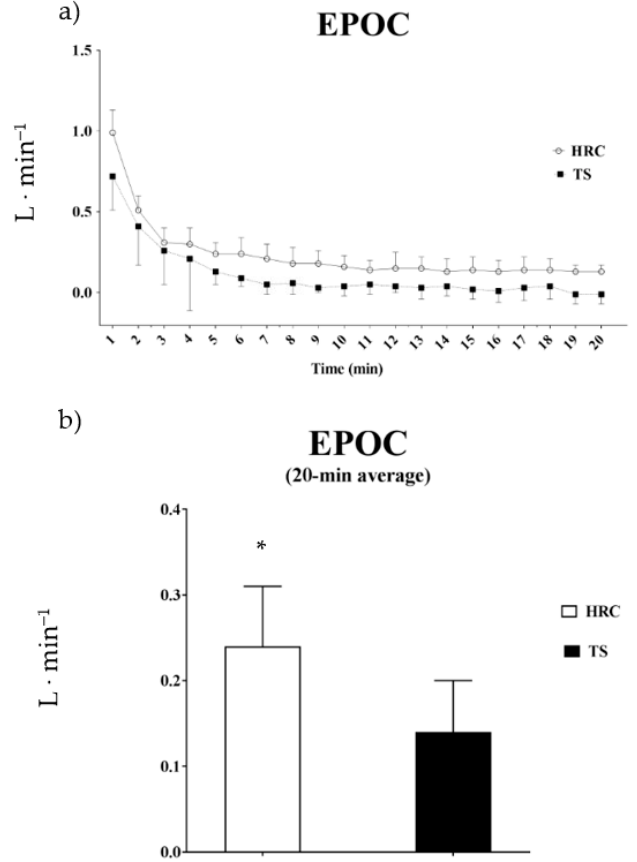
Figure 3. Excess post-exercise oxygen consumption after training session. EPOC = excess post-exercise oxygen consumption after training session. ( a ); excess post-exercise oxygen consumption per minute; ( b ); average of 20-min of excess post-exercise oxygen consumption; HRC = high-intensity resistance circuit-based training; TS = traditional strength training; * = significant differences, p ≤ 0.001.